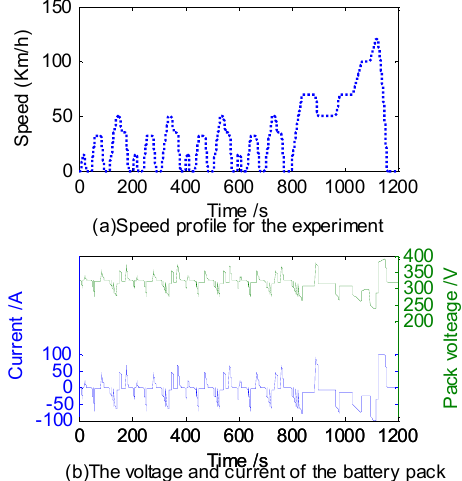
Figure 11. ( a ) Work condition; ( b ) Voltage and current.